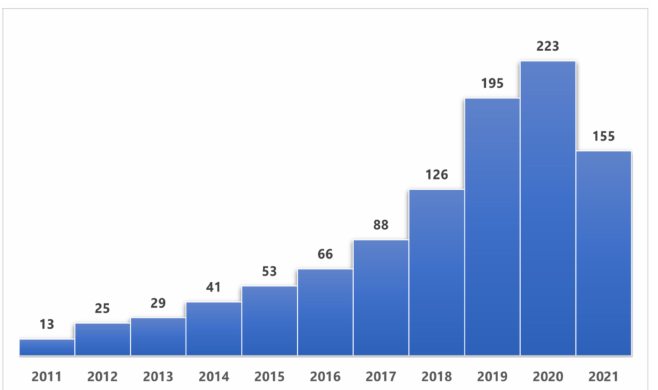
Figure 9. Number of yearly studies conducted on the effects of superhydrophobic nanocoatings in preventing biofilm formation from 2011 to 2021. Data are obtained from a simple search